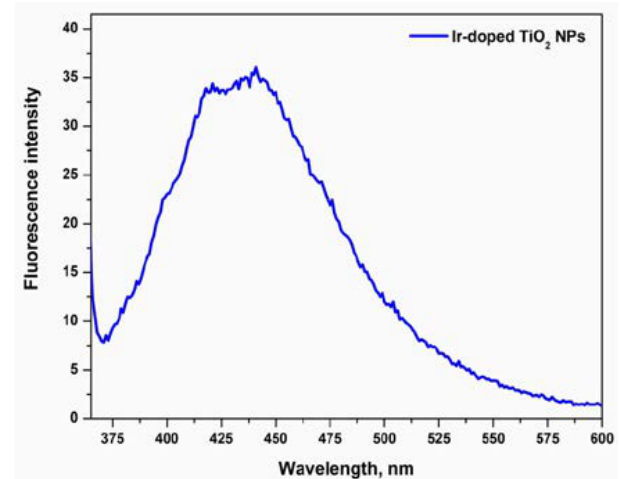
Fig. 2: Photoluminescence spectra of Ir-doped TiO